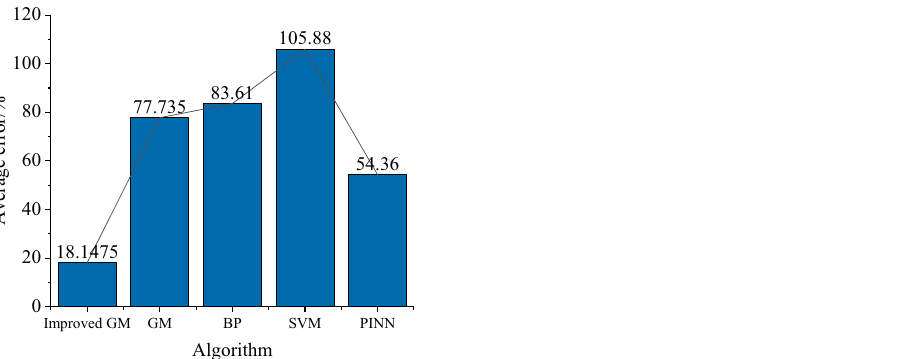
Figure 8. Comparison of average errors.